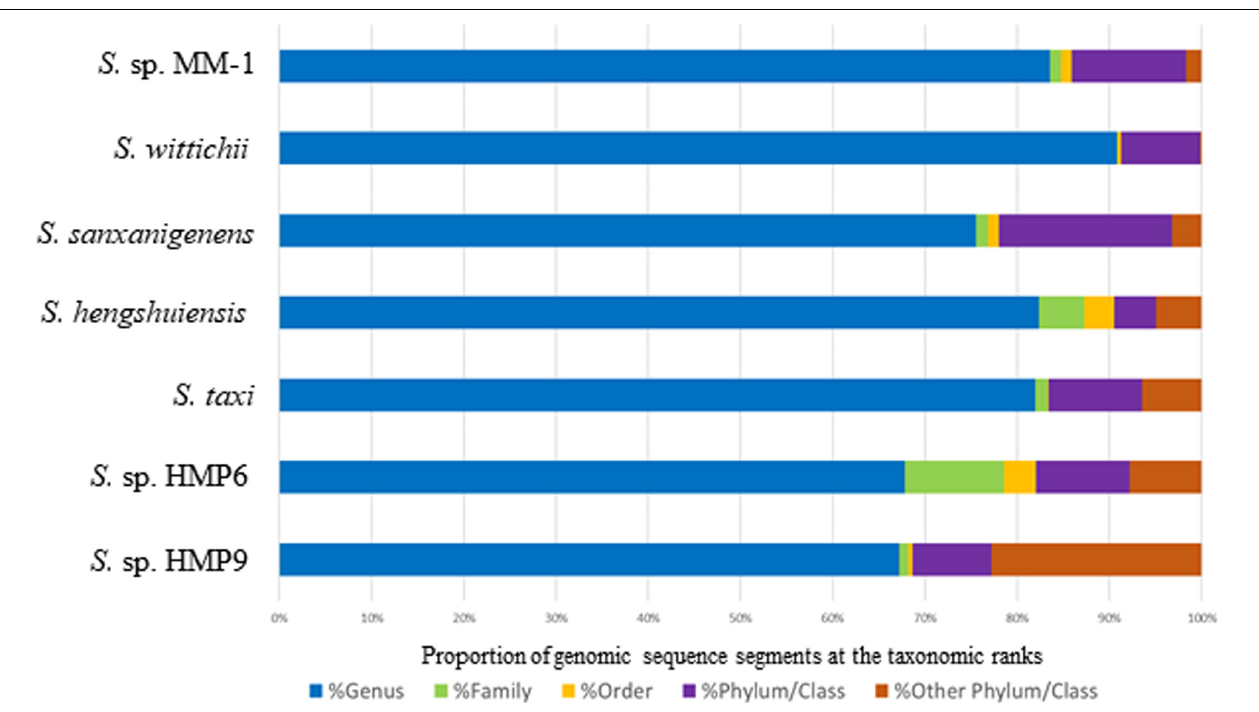
FIGURE 3 | Proportion of genomic sequence segments in the Sphingomonas genome-sequenced strains assigned according to taxonomic rank. The horizontal bars represent proportion of genomic segments assigned to each taxonomic rank by BLSOM with taxonomic ranks color-coded: genus ( (cid:4) ), family ( (cid:4) ), order ( (cid:4) ), phylum/class ( (cid:4) ), and other phylum/class ( (cid:4) ).